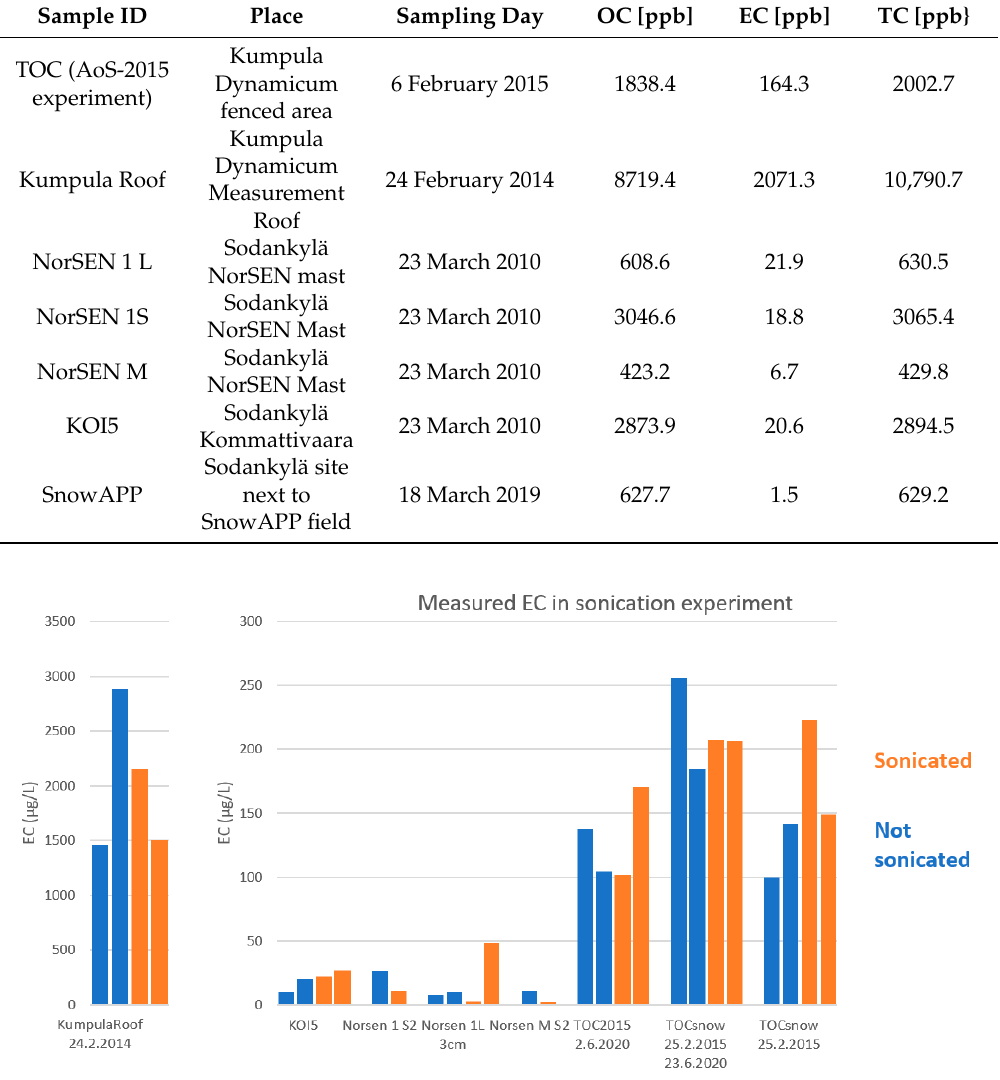
Table 2. Snow sample results of organic (OC), elemental (EC), and total carbon (TC). Number of snow samples analyzed with OCEC n tot = 30. The uncertainty of the OCEC is estimated to be +/ − 0.2 µ gC ( + 5% relative error for higher loaded samples).